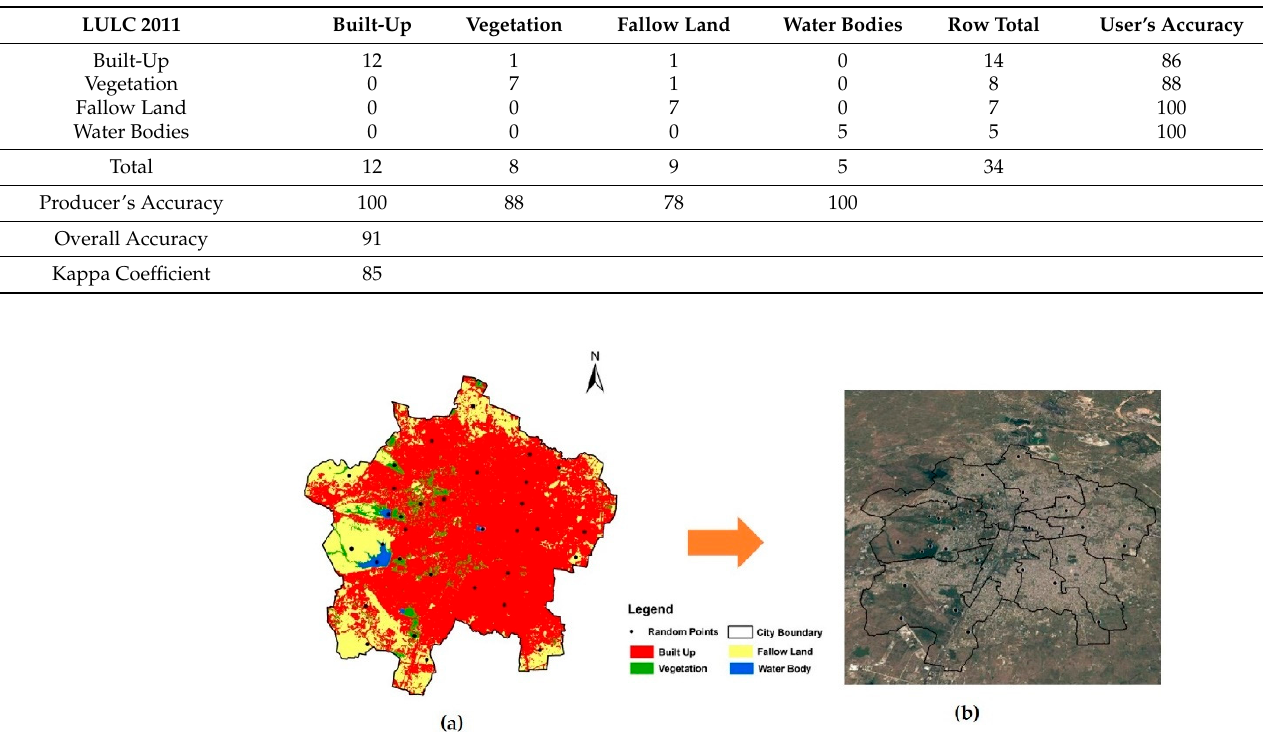
Table A1. Accuracy assessment of LULC-2011.